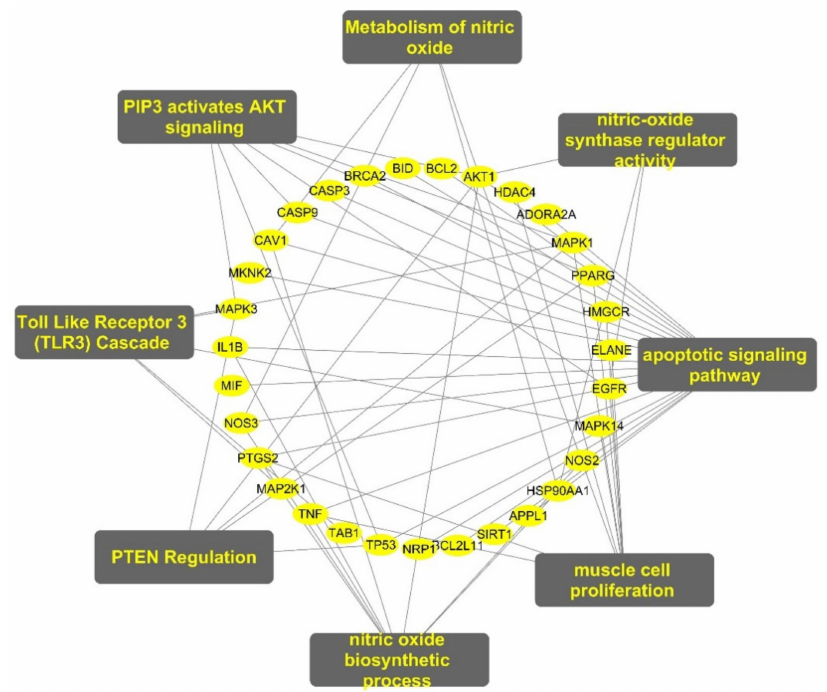
Figure 3. Target-function network. A functional module is linked to the targets if the target is involved in that biological process or